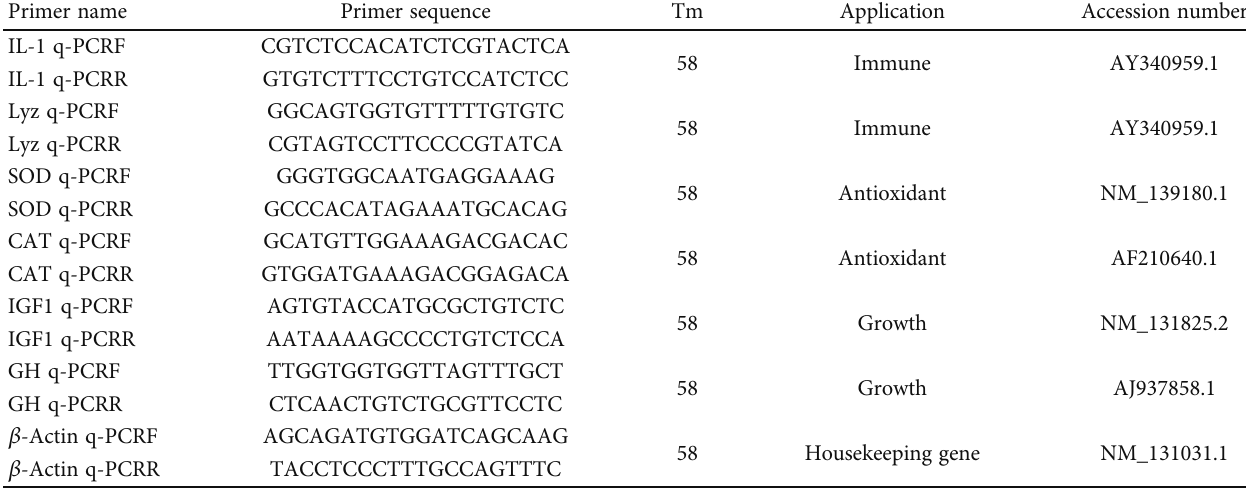
Table 2: Sequence and melting temperature (Tm) primers of selected gene expression related to mucosal immunity, antioxidant, and growth in zebra fi sh [43].